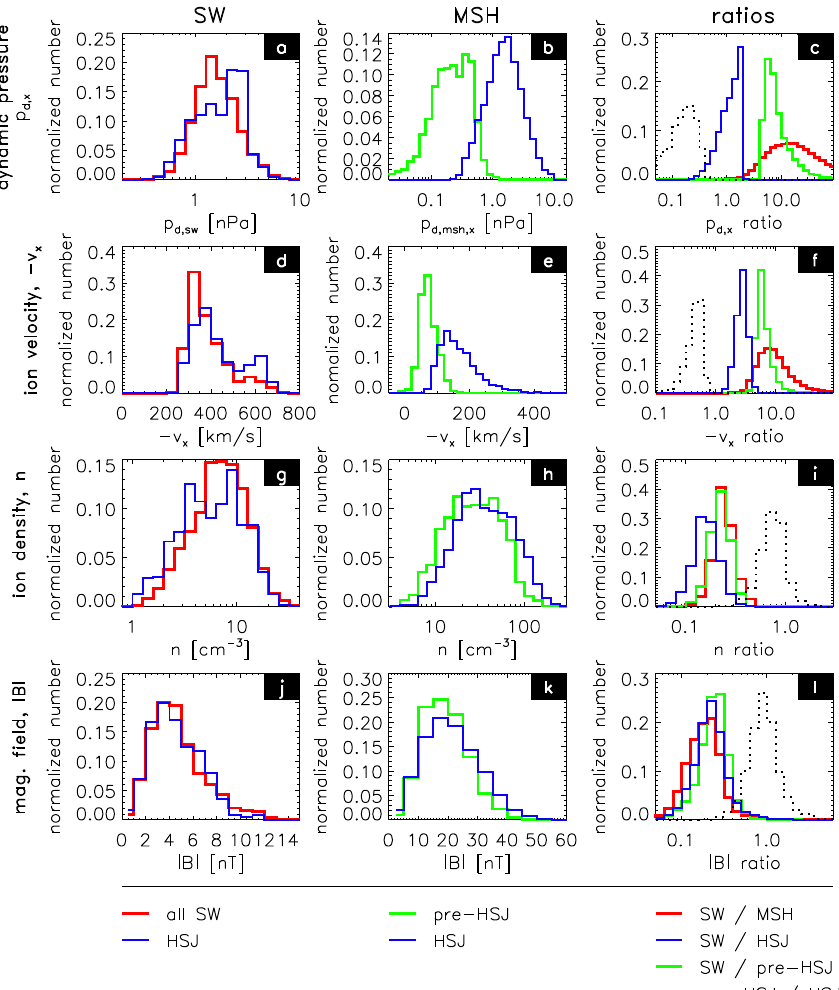
Fig. 5. Distributions of solar wind (SW) and magnetosheath (MSH) data for all sheath intervals, HSJs, and pre-HSJ times, as well as ratio distributions. Rows (top to bottom) correspond to GSE x direction dynamic pressure ( p d , x ) and ion velocity ( − v x ), ion density ( n ), and modulus of the magnetic field ( | B | ) measurements. Left column: distributions of OMNI solar wind data corresponding to HSJ t 0 times (blue) as well as to all times for which magnetosheath measurements are available (red). Middle column: distributions of THEMIS sheath data corresponding to HSJ t 0 times (blue) as well as to pre-HSJ times (green). Right column: ratios of OMNI and THEMIS data: for all selected sheath intervals (red); for HSJ t 0 times (blue); and for pre-HSJ intervals (green). Ratios of pre-HSJ to HSJ data are depicted by dotted black